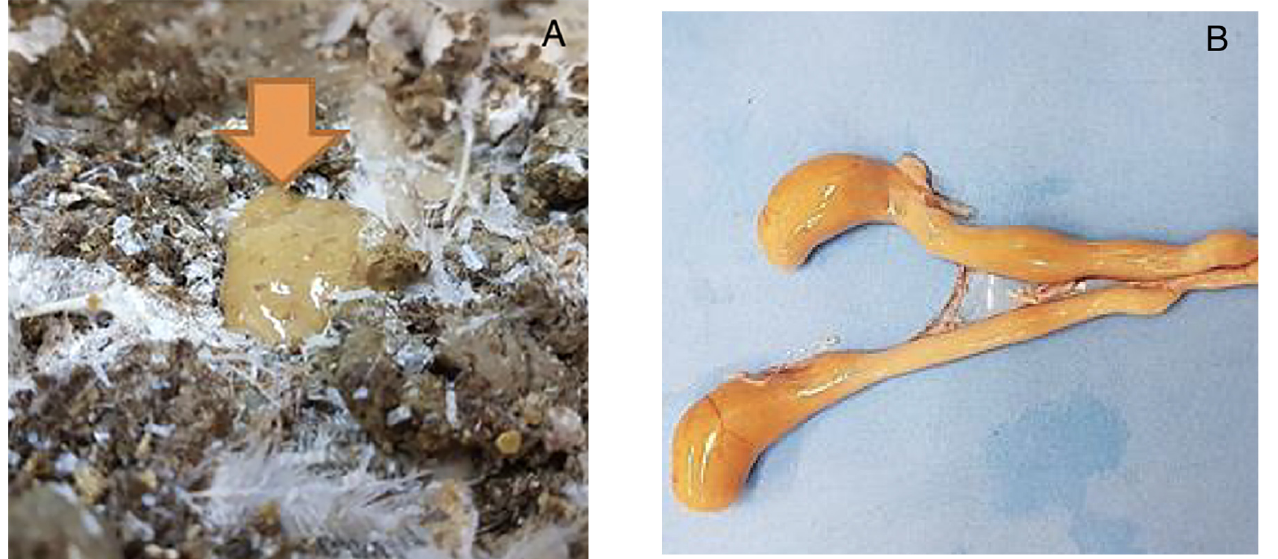
Figure 2. Feces and cecum of birds, four days after the inoculation of A. butzleri AB170 strain. ( A ) The orange arrow shows the diarrheagenic aspect of poultry feces. ( B ) Bird’s ceca with an orange content.